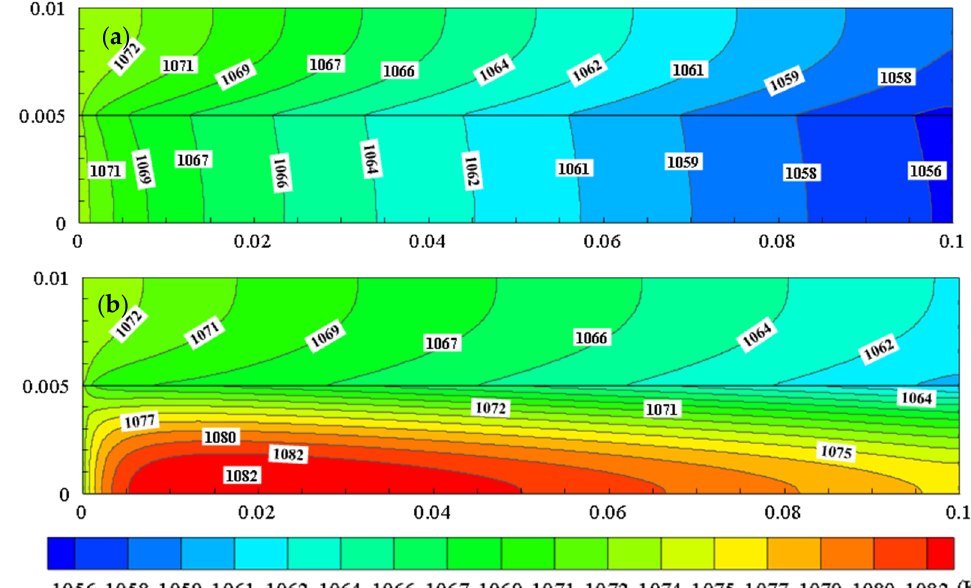
Figure 5. Temperature (K) contours under: ( a ) non − reactive and ( b ) reactive flow on sweep side ( x / r = 0.4).